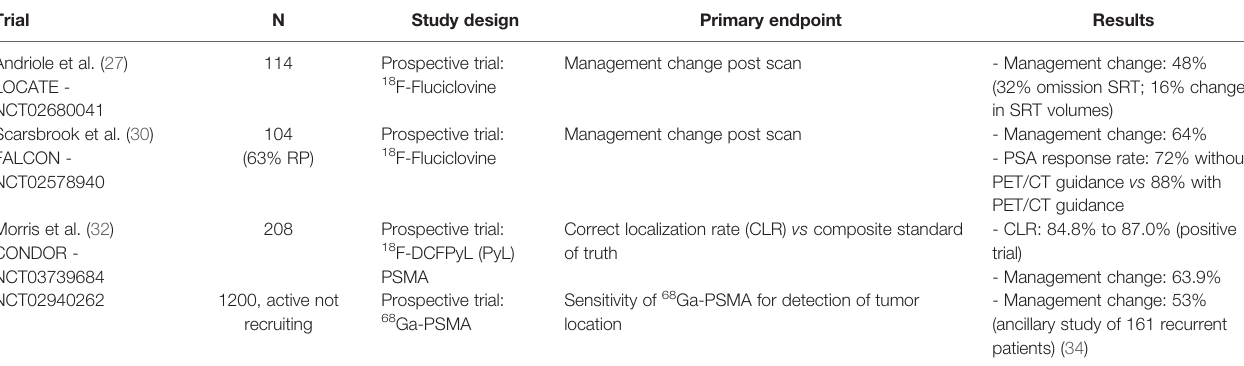
TABLE 1 | Prospective trials evaluating the management change rate after restaging PET/CT in prostate cancer patients with biochemical recurrence after radical prostatectomy. Trial N Study